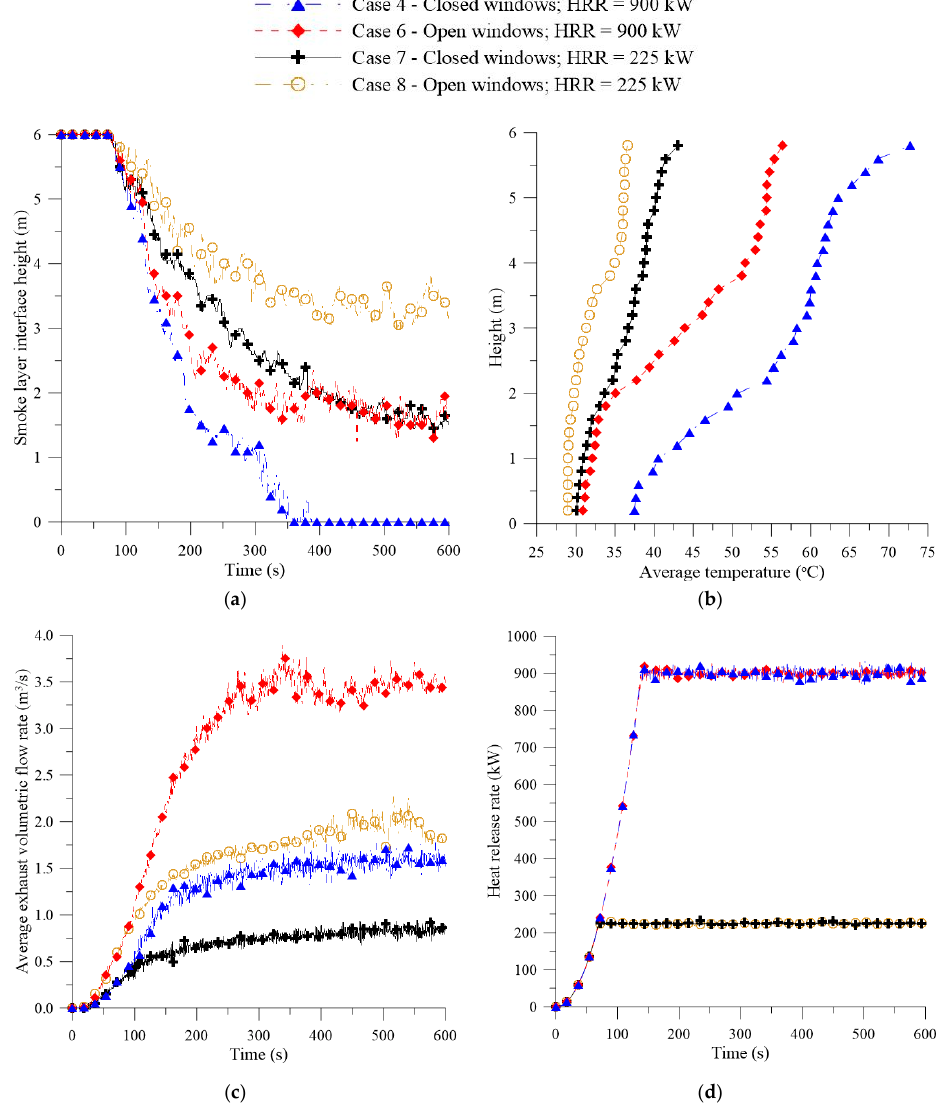
Figure 9. Influence of the HRR in the ( a ) smoke layer vertical displacement; ( b ) average temperature profile at t = 600 s; ( c ) average exhaust volumetric flow rate and ( d ) HRR (compartments with natural exhaust areas of 9.00 m 2 ).